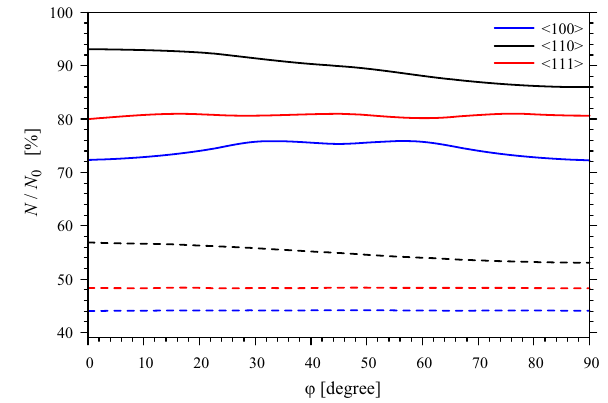
Fig. 11 The percentage of positrons (solid curves) and electrons (dashed curves) that remain in the regime of stochastic deflection up to the end of the crystal for different orientations of the bending plane √ 2 ≈ 35 . 3 ◦ for the (cid:2) 110 (cid:3) orientation of the crystal arctan 2 and 0 for the (cid:2) 111 (cid:3)